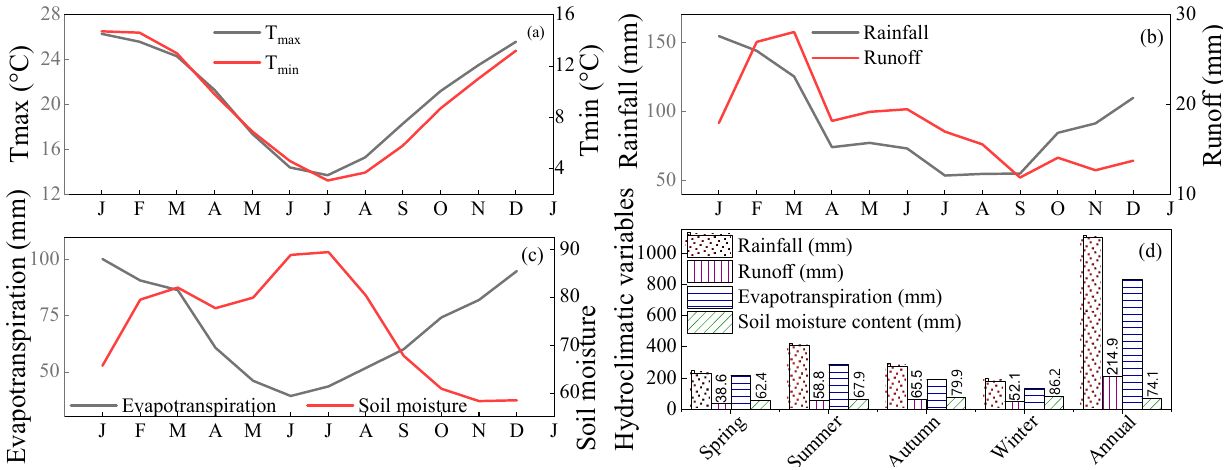
Figure 11. Monthly ( a – c ) and seasonal and annual ( d ) variation in climatological and hydrological variables in Manning River basin in the period of (1977–2016) as a baseline [32].